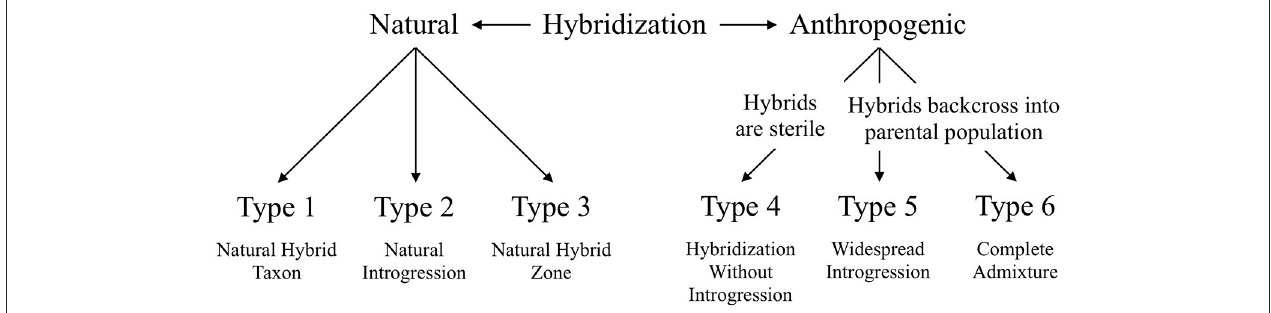
FIGURE 1 | A framework to categorize types of hybridization according to a seminal paper by Allendorf et al. (2001). Types 1–3 are forms of natural hybridization, and the resulting taxa should be eligible for conservation. Types 4–6 are forms of anthropogenic hybridization, and the three categories have different consequences from a conservation perspective.